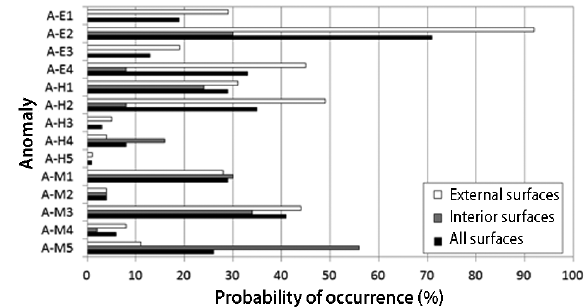
Fig. 24. Probability of finding each anomaly in one wall considering external surfaces, interior surfaces and all surfaces (adapted from Sá et al. 2015)